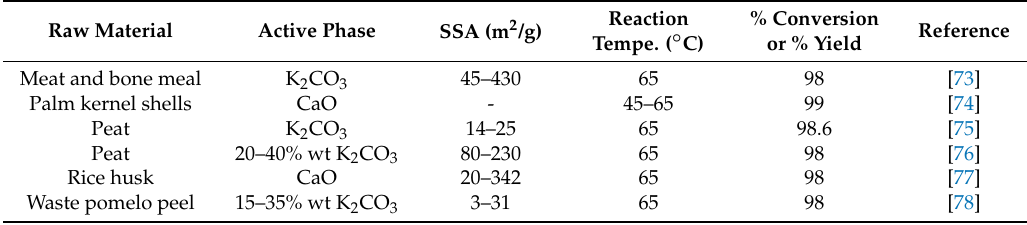
Table 2. Use of base solid biochars as catalysts for transesterification/esterification reaction in biodiesel production.